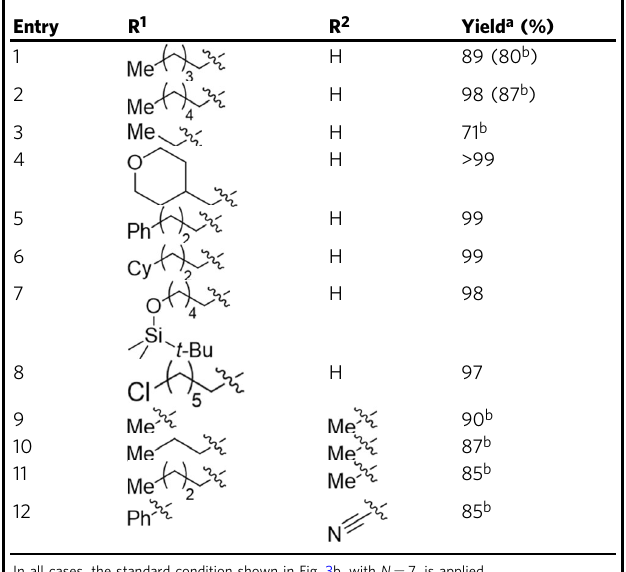
Table 1 Yield for the electrochemical partial oxidation of various primary (entry 1 – 8) and secondary (entry 9 – 12) alcohols by o-SWNT/PTFE